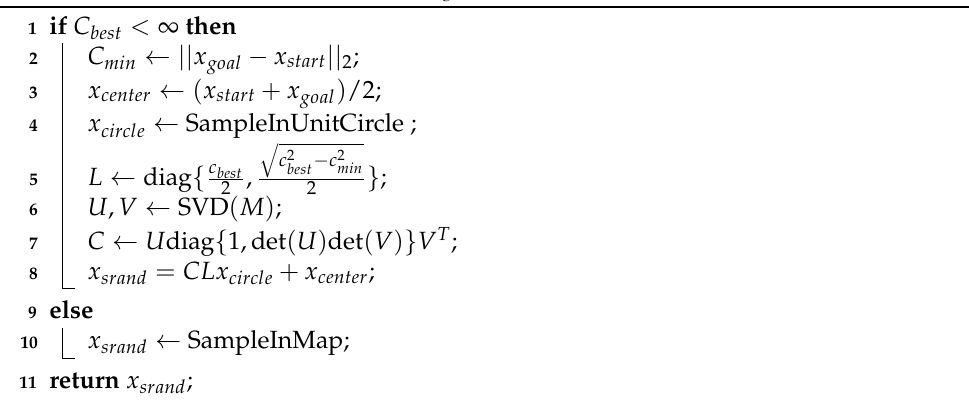
Algorithm 1: InformedSample( x start , x goal , C best